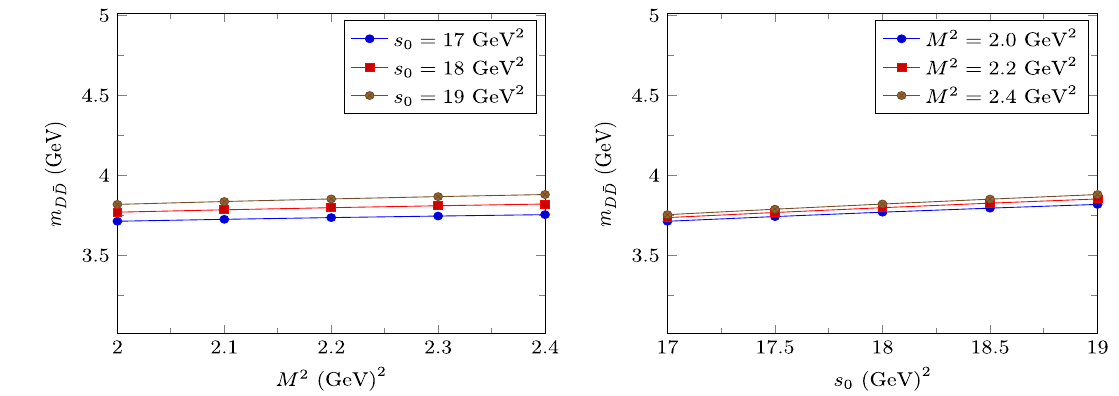
Fig. 1 The mass of the D ¯ D state as a function of M 2 at fixed s 0 (left panel), and as a function of s 0 at fixed M 2 (right panel)